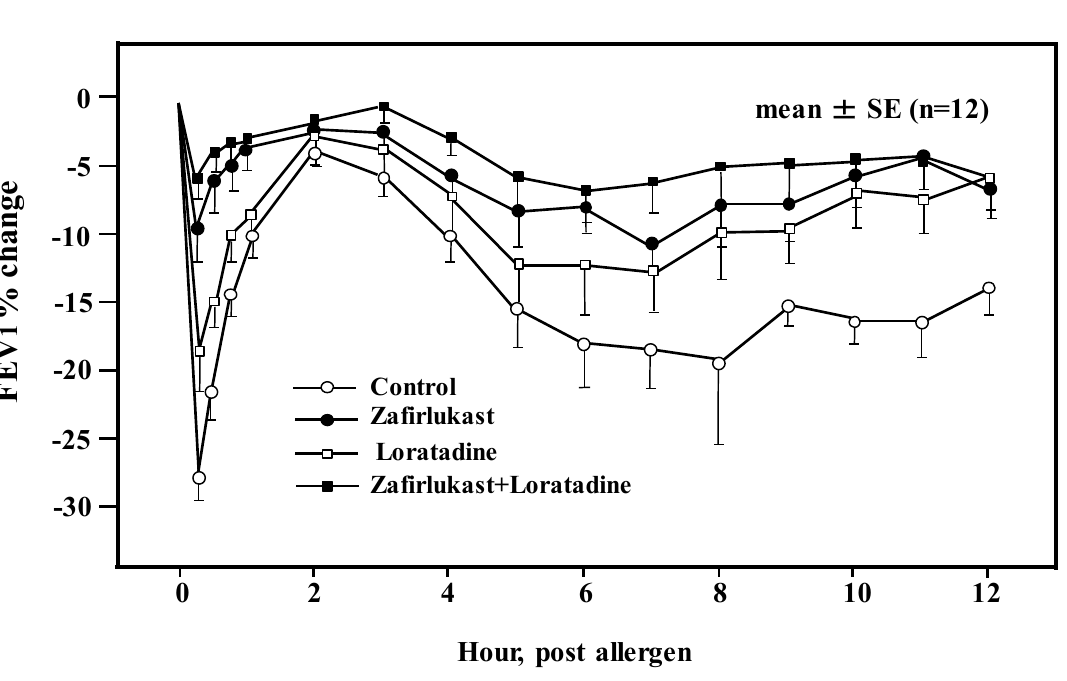
Figure 5. Time course of allergen-induced early and late airway reaction after different treatment strategies in the subjects. Pulmonary function, expressed as percent of postdiluent FEV 1, was followed hourly for 12 h. The figure was modified from reference [45] with permission: Roquet et al., Combined antagonism of leukotrienes and histamine produces predominant inhibition of allergen-induced early and late phase airway obstruction in asthmatics. Am. J. Respir. Crit. Care Med. 1997, 155 ,